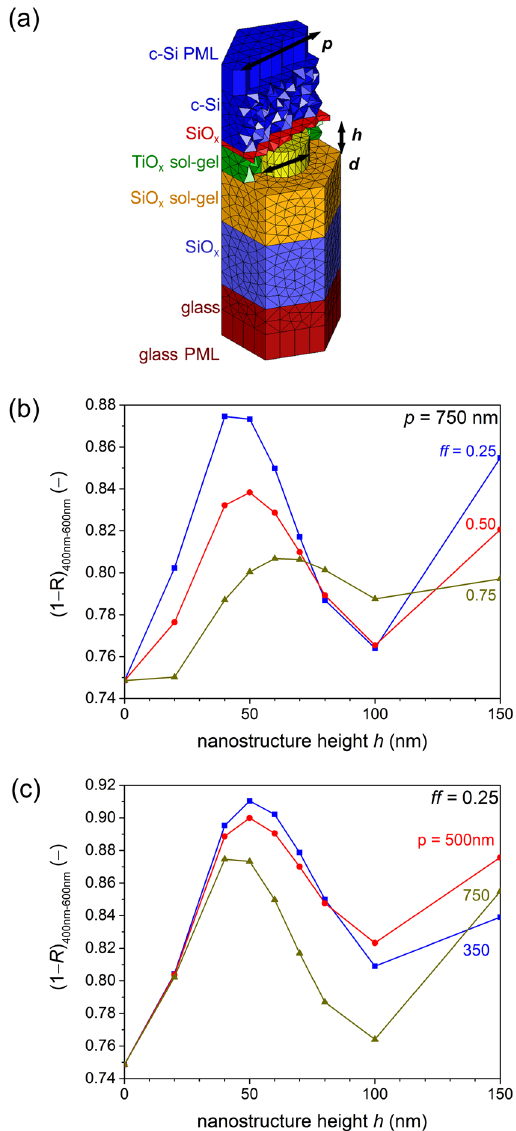
Figure 3. ( a ) Unit cell of the SMART texture used for 3-dimensional optical simulations, consisting of a hexagonal array of SiO x nano-pillars and the smoothing TiO x layer. The parameters varied in the simulations are denoted, namely the period ( p ), the height ( h ) and the diameter ( d ). On bottom and top, infinite halfspaces of glass and silicon layers are assumed, which is realized with perfectly matched layers (PML). Mean 1 − R (reflectance) between 400 nm and 600 nm, calculated with 3-dimensional FEM simulations for ( b ) different filling fractions ff with a fixed period of 750 nm, and ( c ) various periods p of the nanostructure with a fixed filling fraction of